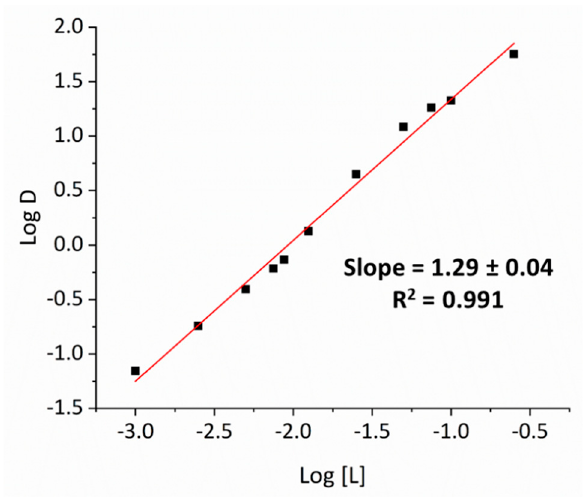
Figure 3. Slope analysis for the transport of Ga by [MTOA][I]. Conditions: GaCl 3 (0.01 M) in HCl (2.0 M, 2 mL), contacted with [MTOA][I] (0.001 to 0.25 M) in toluene (2 mL) for 1 h at RT with magnetic stirring.